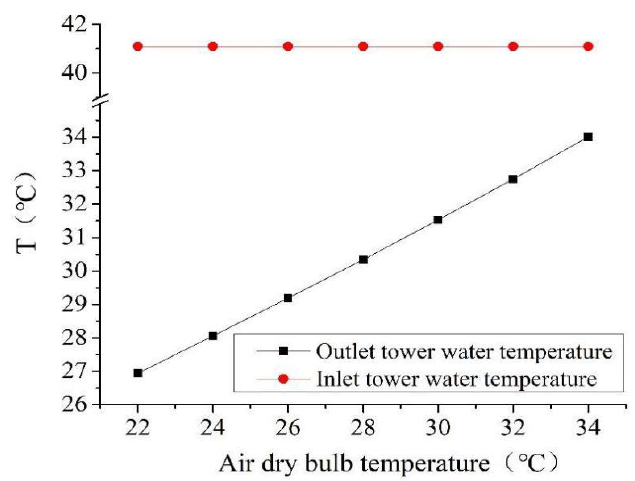
Energies 2020 , 13 , x FOR PEER REVIEW Figure 12. Outlet water temperature with di ff erent air-dry bulb temperature. Figure 13. Evaporation loss at vary air dry bulb temperature. Figure 12. Outlet water temperature with different air-dry bulb temperature.